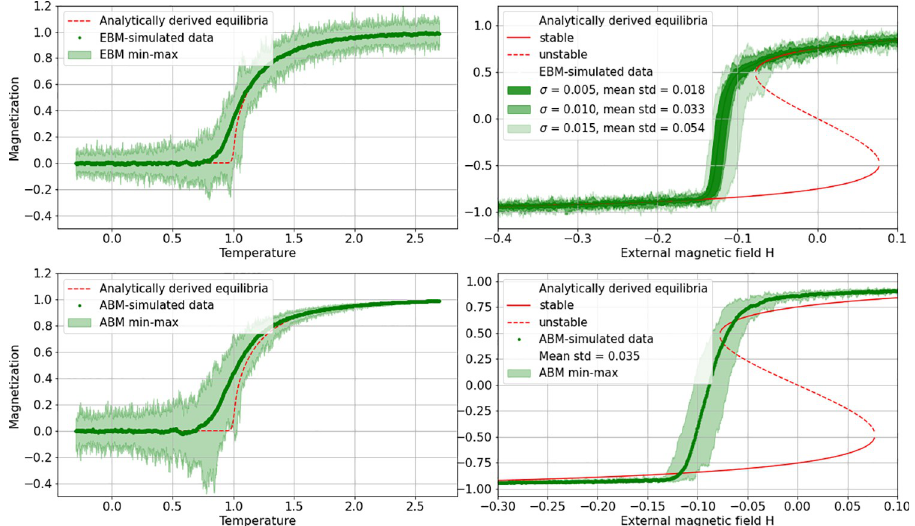
Fig 2. Simulation data of EBM and ABM Ising implementations. Simulation data (min, mean, max from 100 realizations each) and analytically derived equilibria of Ising implementations as EBM (top row) and ABM (bottom row) with pitchfork (left column) and combined saddle node bifurcation (right column). Noise in the case of the EBM realizations has been added according to Eq 1. Note how in the case of the ABM realization the change in noise level distributes like expected primarily around the bifurcations, while in the EBM case noise is more equally distributed (since added) over all simulated data. Additionally, in the EBM saddle-node case the noise-addition has been adjusted (see below for details) so that the signal’s standard deviation (std) best resembles the one of the ABM data. Obviously, a noise level of σ = 0.01 comes close to the one from the ABM realizations. The analytically derived equilibria-curves (red) in the ABM realizations (right column) are generated from the EBM-model and hence approximations. In particular the ABM saddle-node data (bottom right) deviates significantly from these theoretic equilibria.